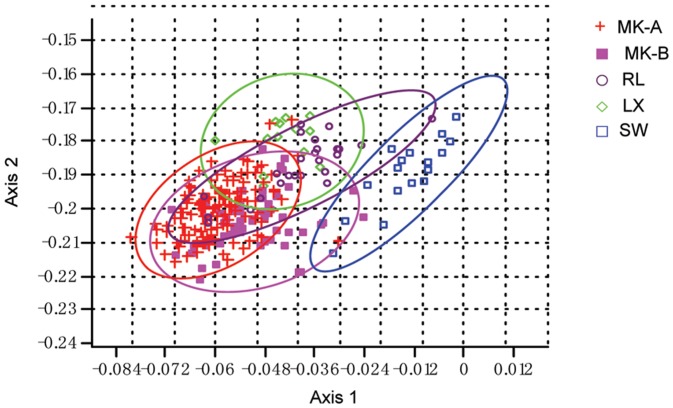
Canonical variate analysis (CVA) based on morphological characters of inferred mitochondrial lineages of P. huangchuchieni.